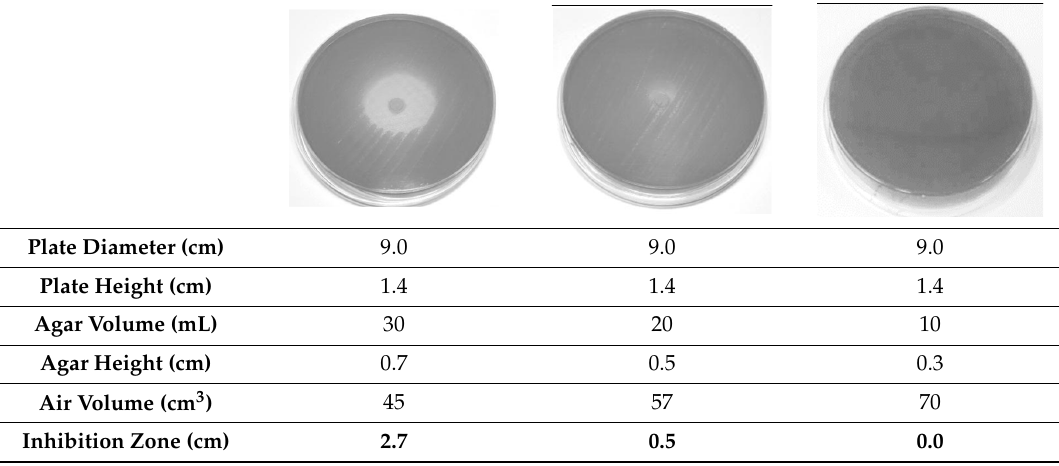
Table 2. Dependence between agar height in the Petri dish and the size of S. aureus growth inhibition